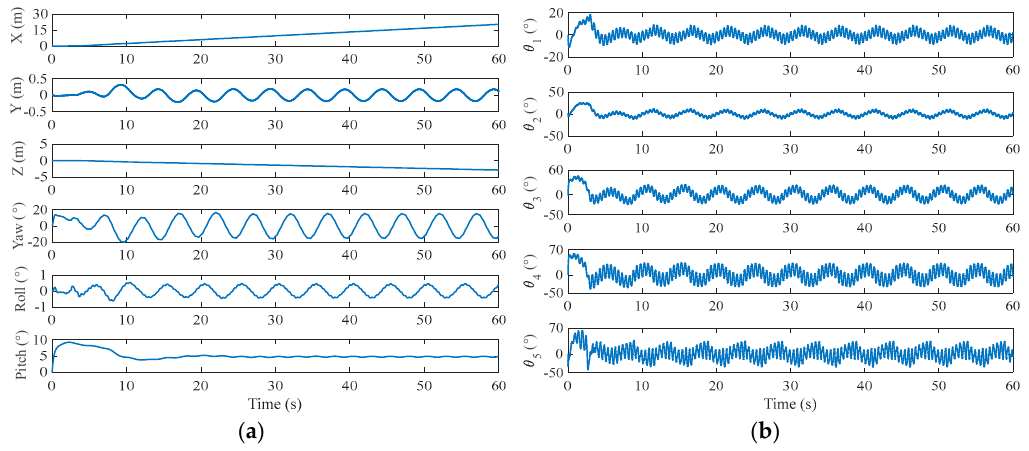
Figure 21. P 1 tracking responses: ( a ) 6-DoF responses; ( b ) Link angles.